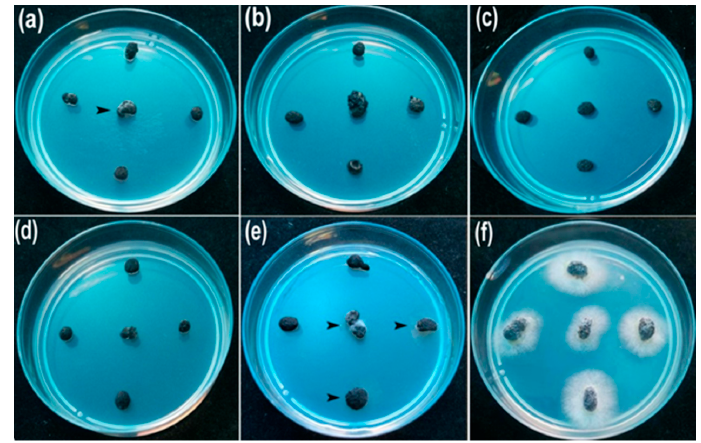
Figure 6. Effect of different concentrations of AgNPs on myceliogenic germination of sclerotia on PDA Figure 6. E ff ect of di ff erent concentrations of AgNPs on myceliogenic germination of sclerotia on PDA for 3 days: ( a ) 50 μ g/mL; ( b ) 100 μ g/mL; ( c ) 150 μ g/mL; ( d ) 200 μ g /mL; ( e ) 50% cell ‐ free culture liquid for 3 days: ( a ) 50 µ g / mL; ( b ) 100 µ g / mL; ( c ) 150 µ g / mL; ( d ) 200 µ g / mL; ( e ) 50% cell-free culture liquid (CFCL); ( f ) ddH 2 O. (CFCL); ( f ) ddH 2 O.